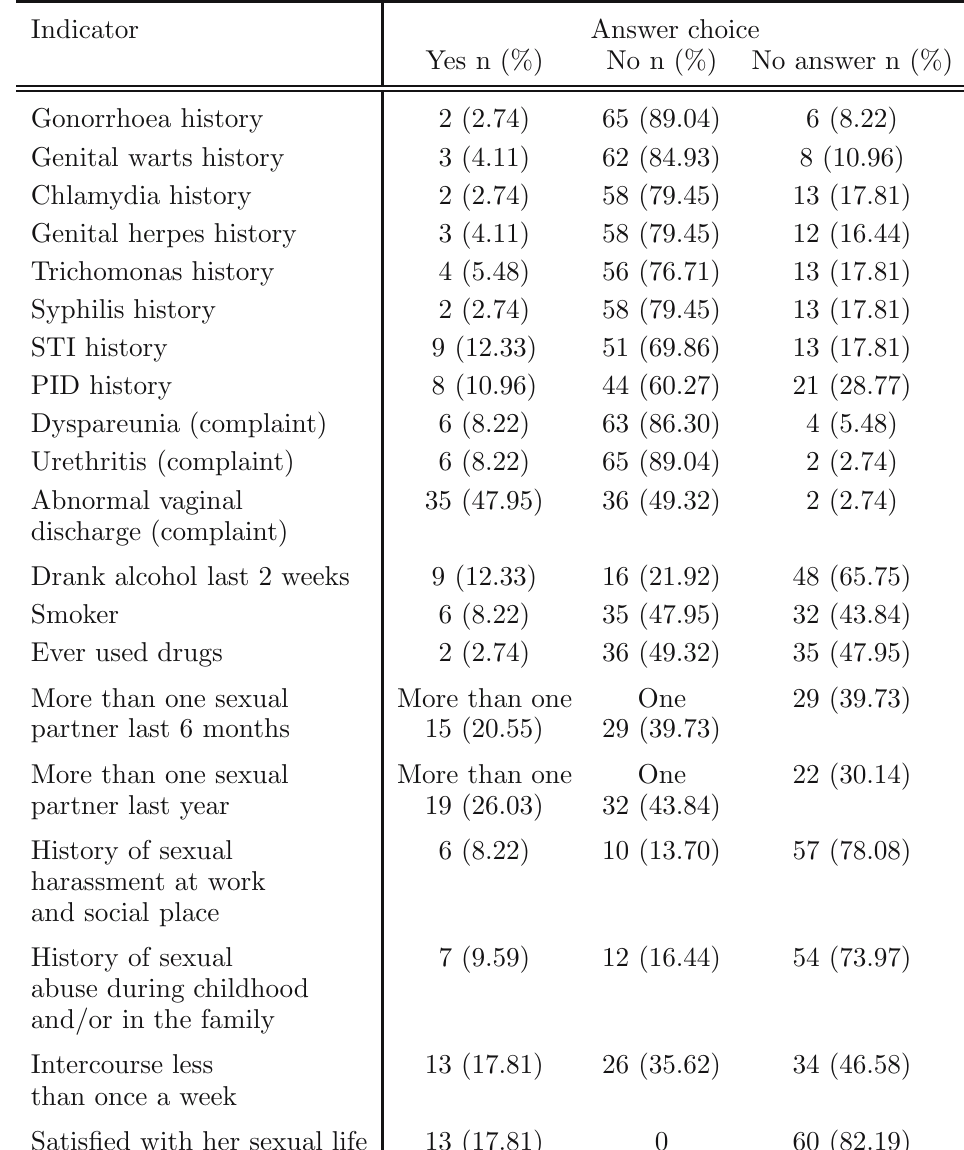
Table 5 Some characteristics of non-responders to the question regarding rape history with respect to history of treatable sexually transmitted infections, gynaecological com- plaints at the time of interview, risk-taking behaviour, and other types of sexual violence